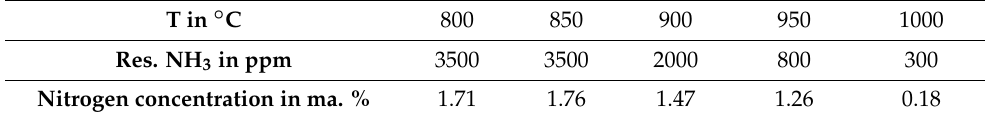
Table 1. Measured NH 3 concentration during carbonitriding in the Solo system for 8 h with C P = 0.6% and a target residual ammonia concentration of 3500 ppm at different temperatures and resulting nitrogen concentration at the surface of the material X38CrMoV5-3.